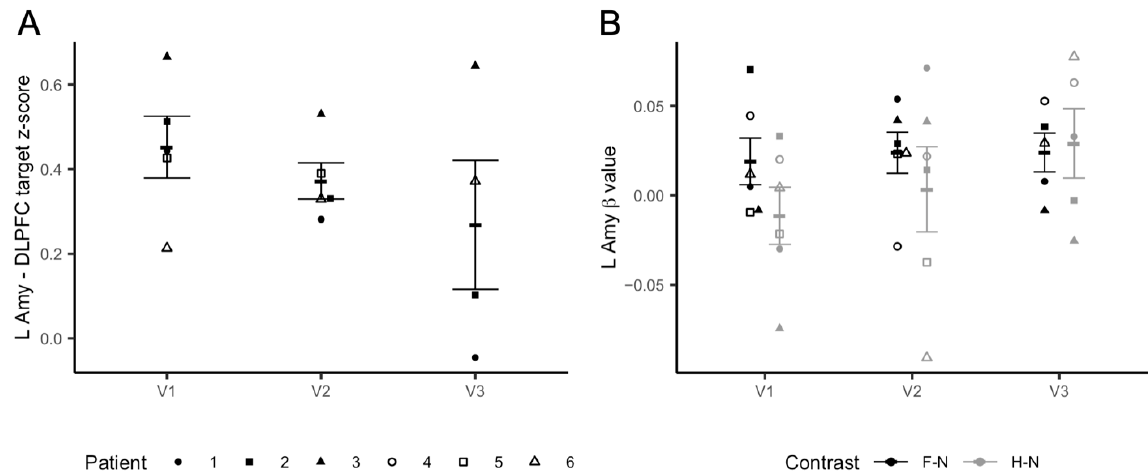
Figure 3. Imaging results. Panel ( A ) shows changes in rsFC between the individualized DLPFC target and the left amygdala. The y axis represents changes in z-transformed region-to-region correlation strength as a result of iTBS. Panel ( B ) shows changes in the left amygdala reactivity to fearful to neutral (F–N) vs. happy–neutral (H–N) faces during the fMRI task. The y axis represents left amygdala beta values. Error bars represent SEM.